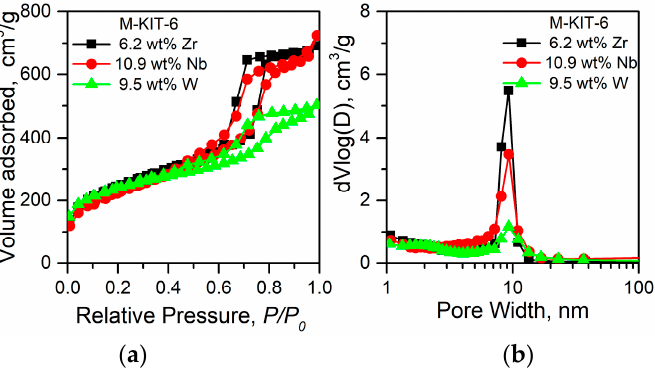
Figure 1. ( a ) Representative nitrogen sorption isotherms, and ( b ) pore size distributions of M-KIT-6, at various metal loadings.